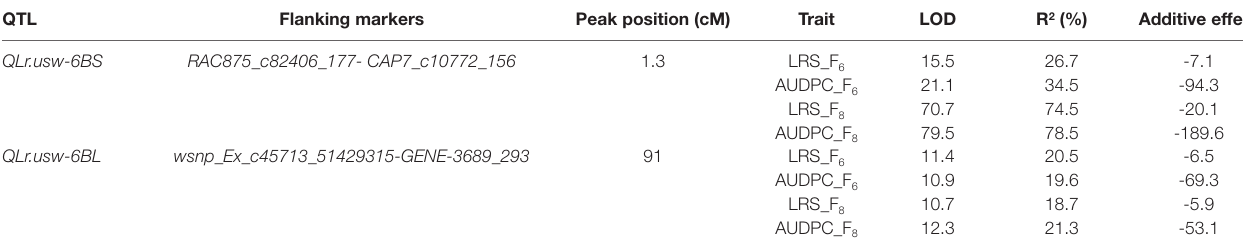
TABLE 3 | Leaf rust resistance QTL detected by CIM in the Gaza/ATRED #2